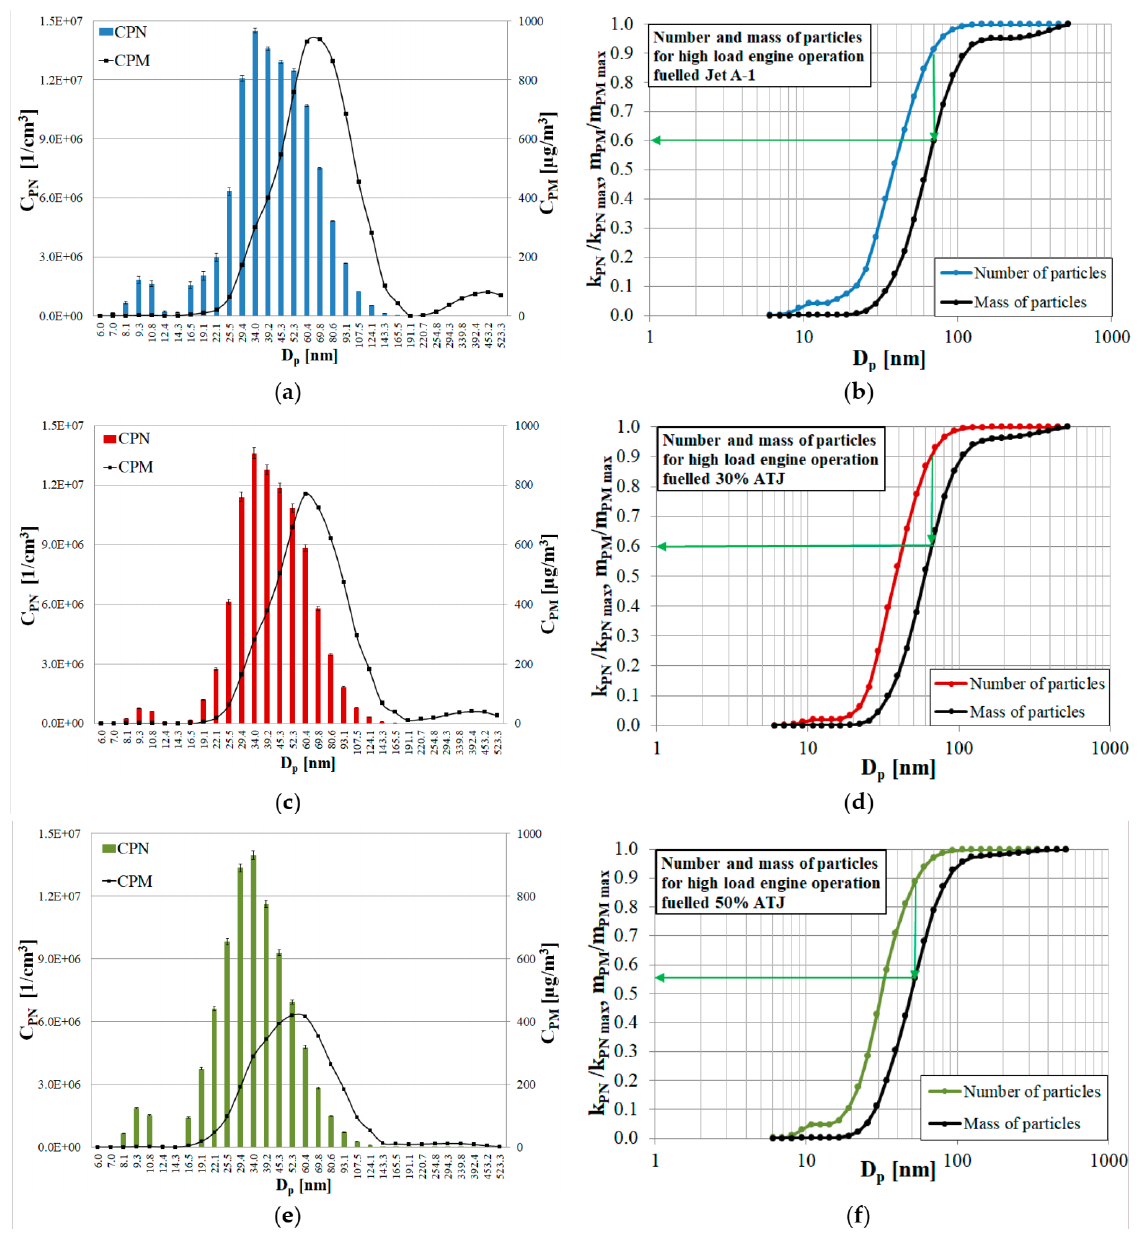
Figure 7. Number and mass concentration of particles depending on their diameter ( a , c , e ) and cumulative values of the relative particles number and relative mass of particulate matter ( b , d , f ) for high engine operation load fueled Jet A-1 ( a , b ), 30% ATJ ( c , d ) and 50% ATJ ( e , f